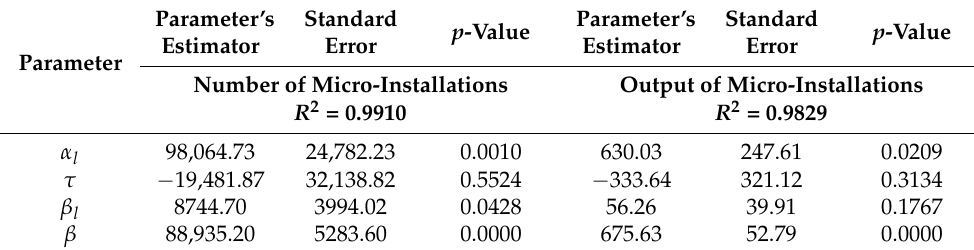
Table 2. Number of electricity prosumers in Poland in the period